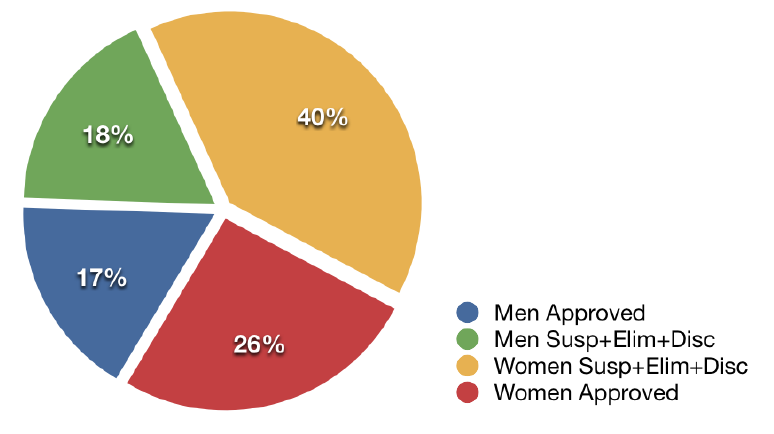
Figure 8: First time donors Approved and Not Approved (suspended, eliminated and discarded unit)